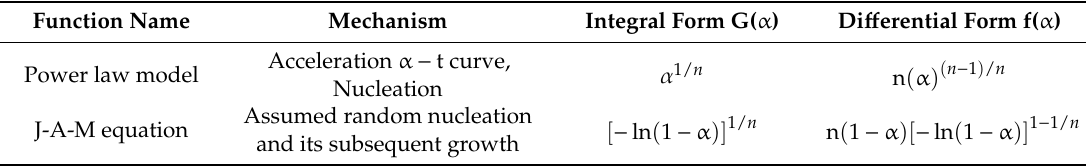
Table 4. Power-law model and the J-A-M equation. Table 5. Modified power-law model and the J-A-M equation.